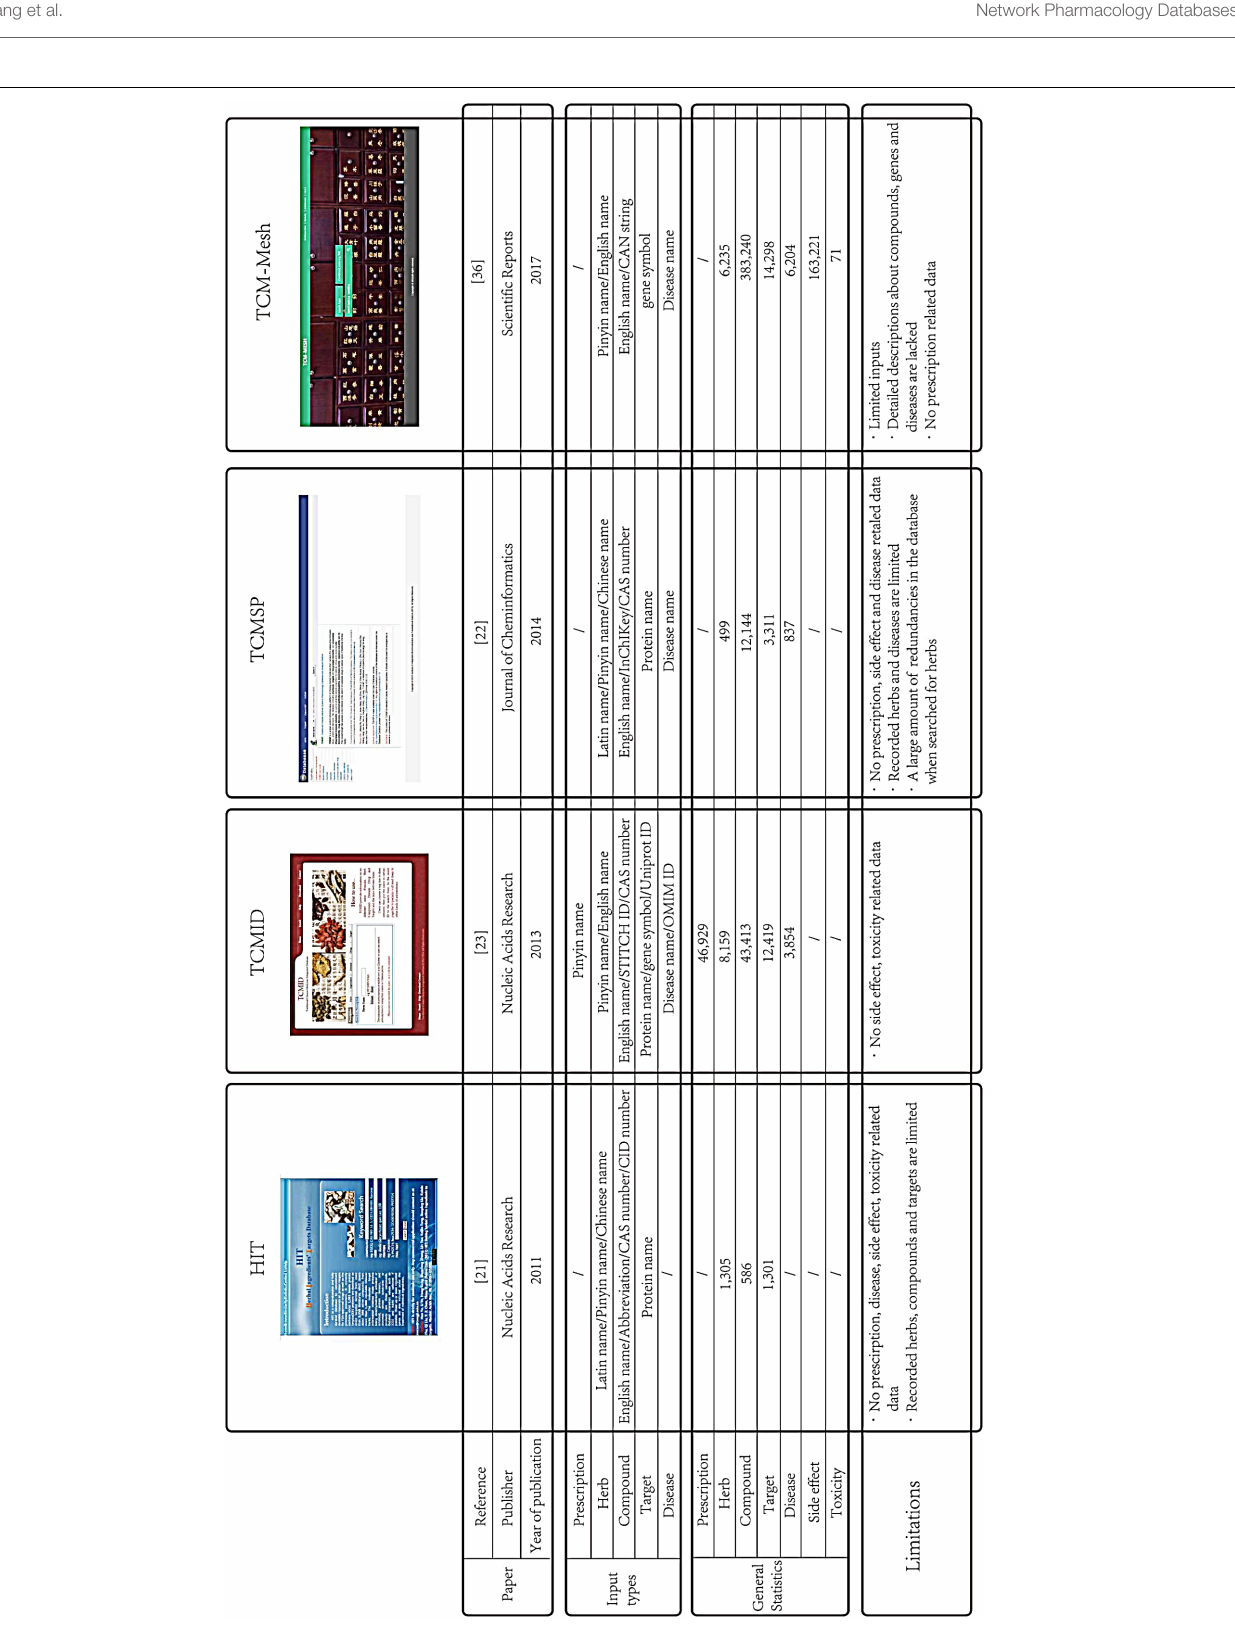
Frontiers in Pharmacology |